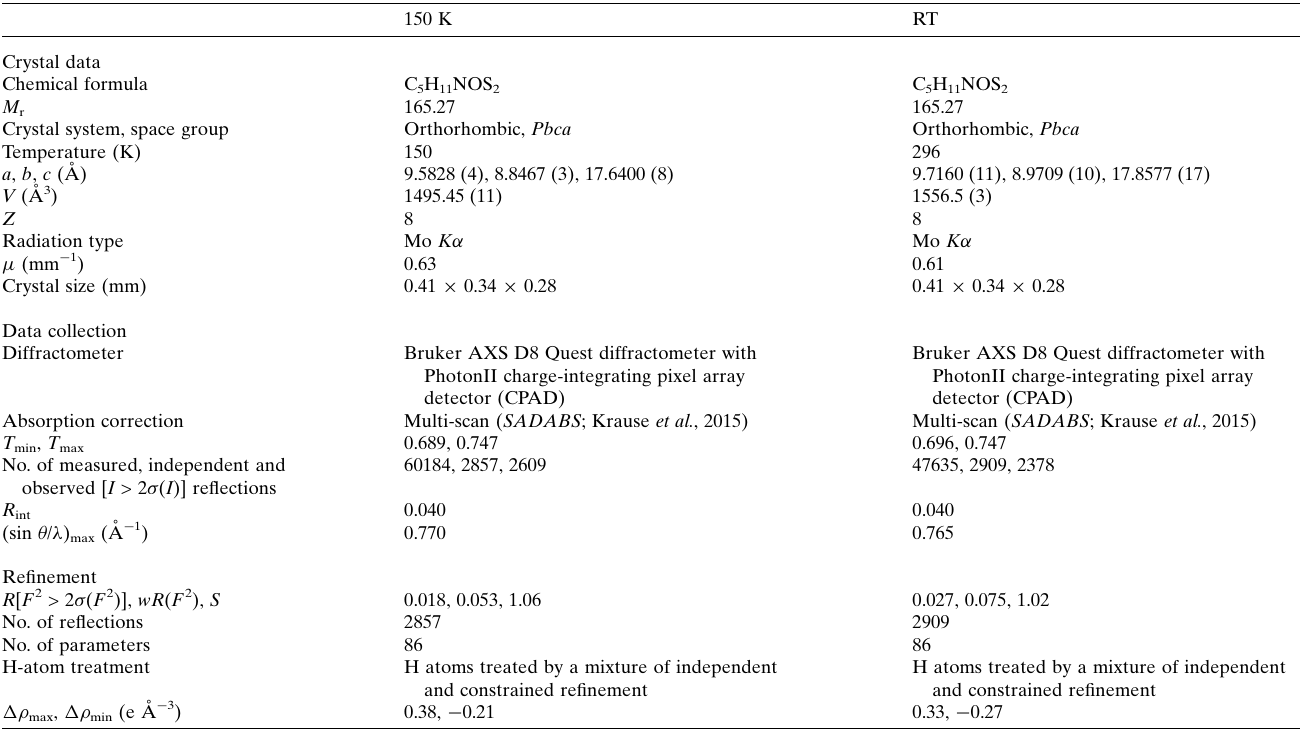
Table 4 Experimental